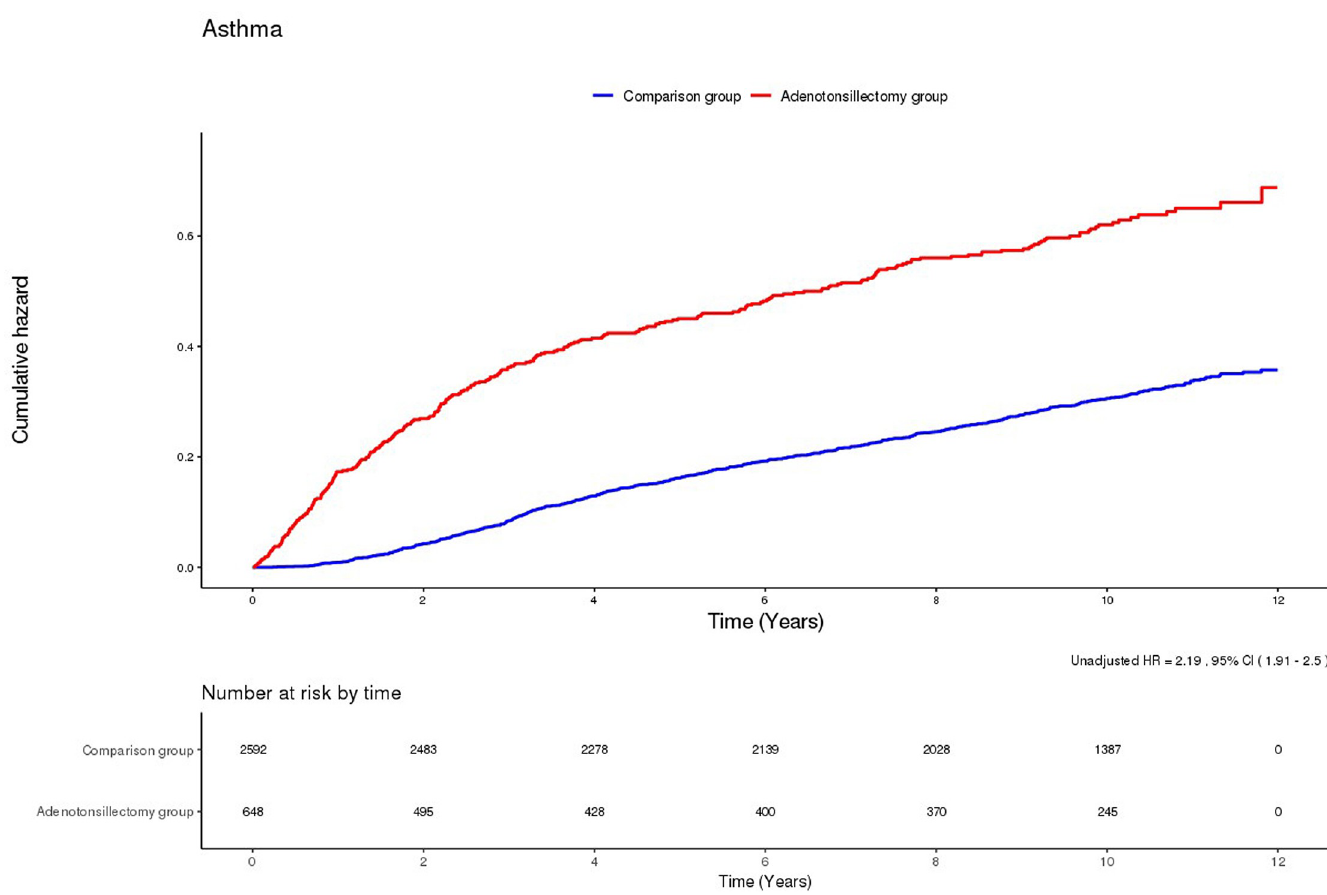
Fig 2. Kaplan-Meier survival curves and log-rank tests for the development of asthma.